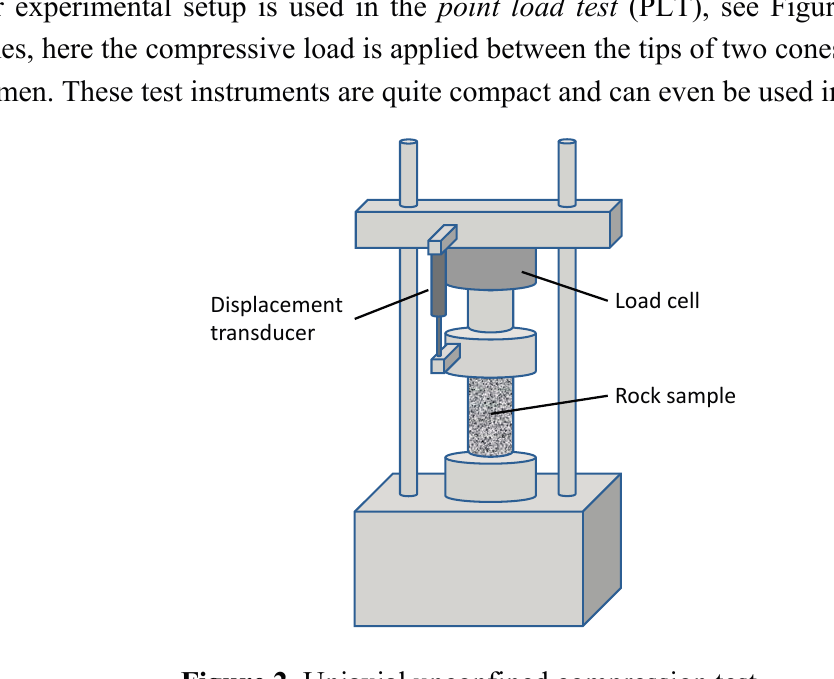
Figure 2. Uniaxial unconfined compression test.